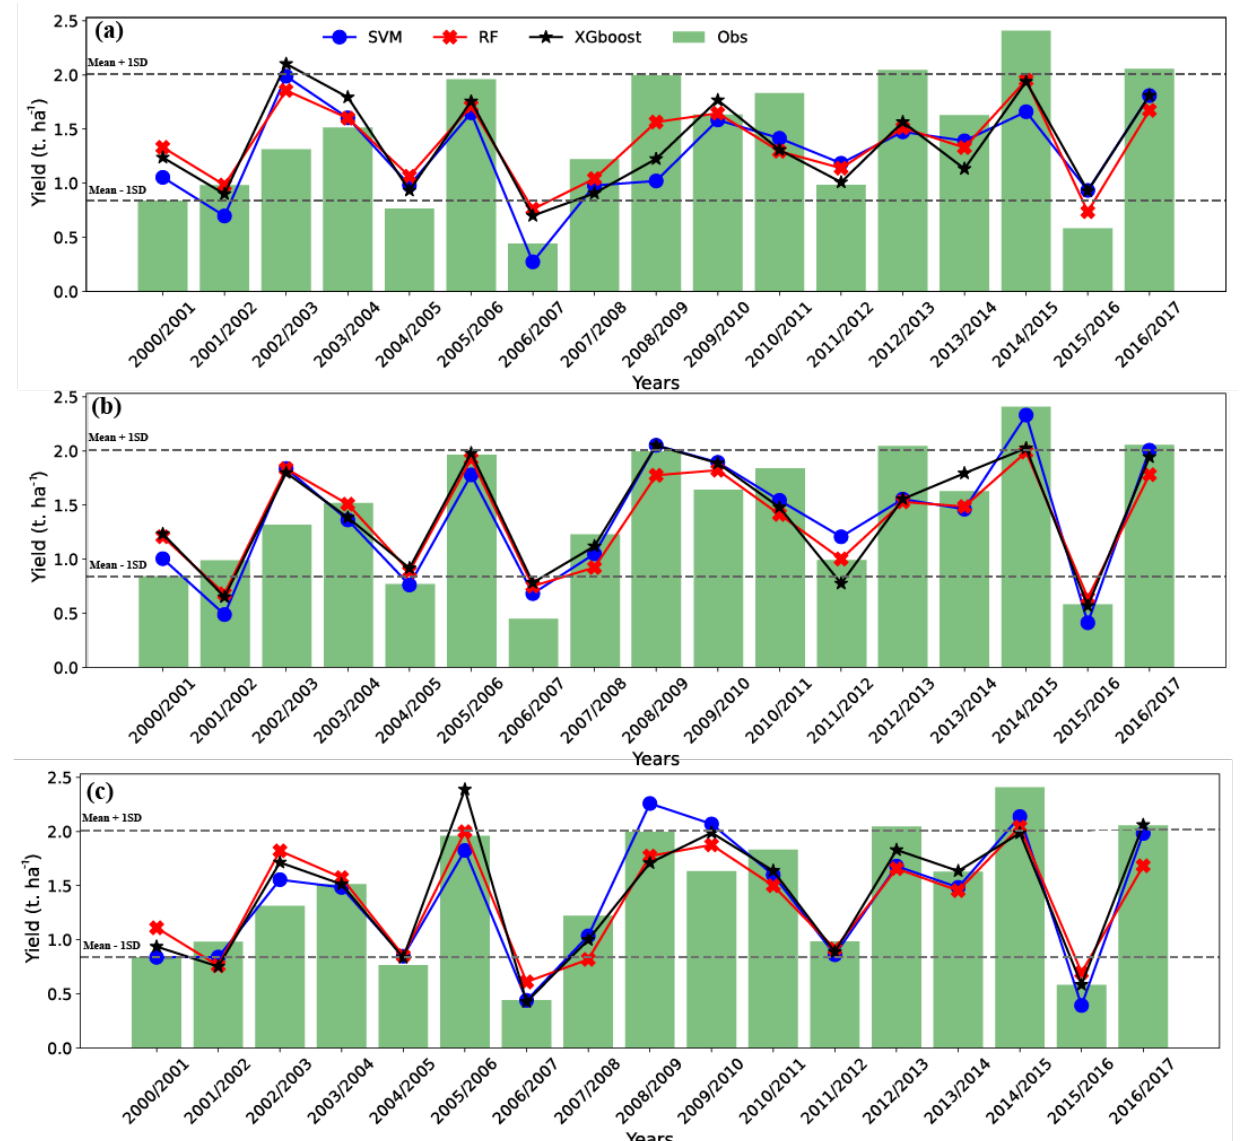
Figure 5. Average of observed and predicted yields using the “leave-one-year-out” technique at ( a ) January, ( b ) February and ( c ) March.